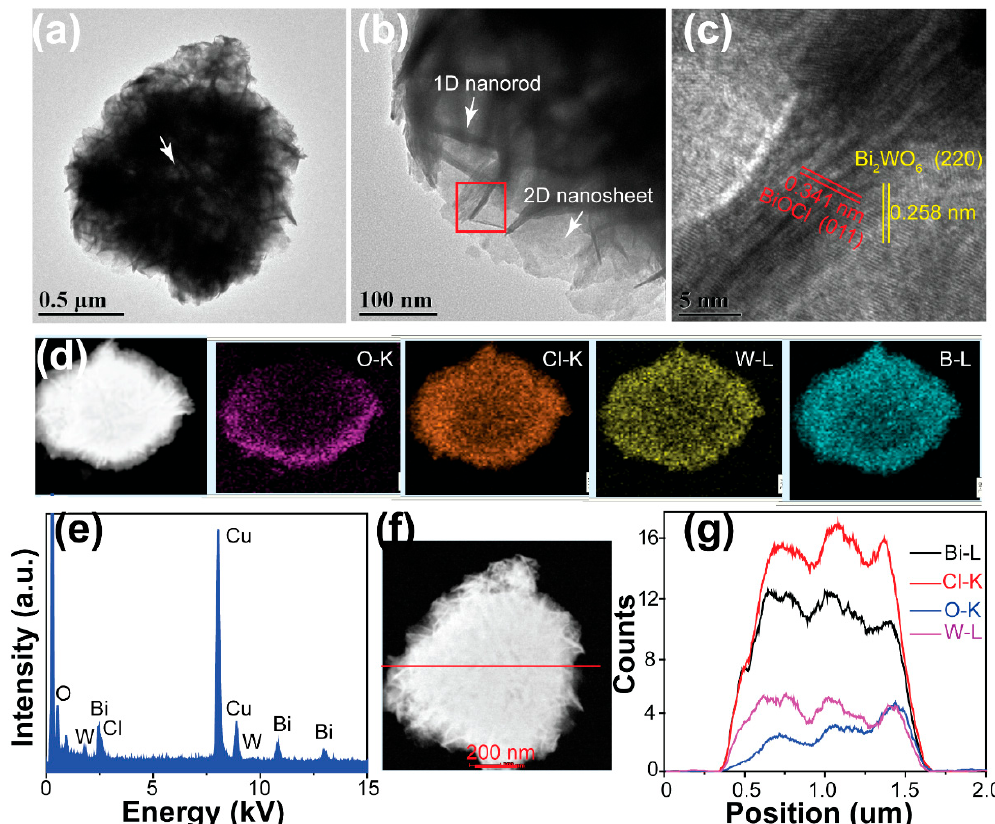
Figure 3. ( a ) Low-magnification and ( b ) high-magnification transmission electron microscopy (TEM) images, ( c ) high-resolution transmission electron microscopy (HRTEM), ( d ) High-angle annular dark field scanning transmission electron microscopy (HAADF-STEM) image and mapping results, and ( e ) EDX spectra of the BiOCl/Bi 2 WO 6 hybrids. ( g ) Line scanning profiles of Bi, Cl, O and W recorded along the line shown in ( f ).